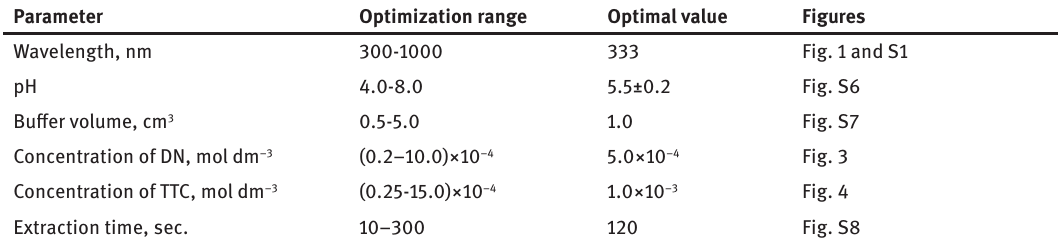
Table 1. Extraction-spectrophotometric optimization of the V IV -DN-TTC-water-chloroform system